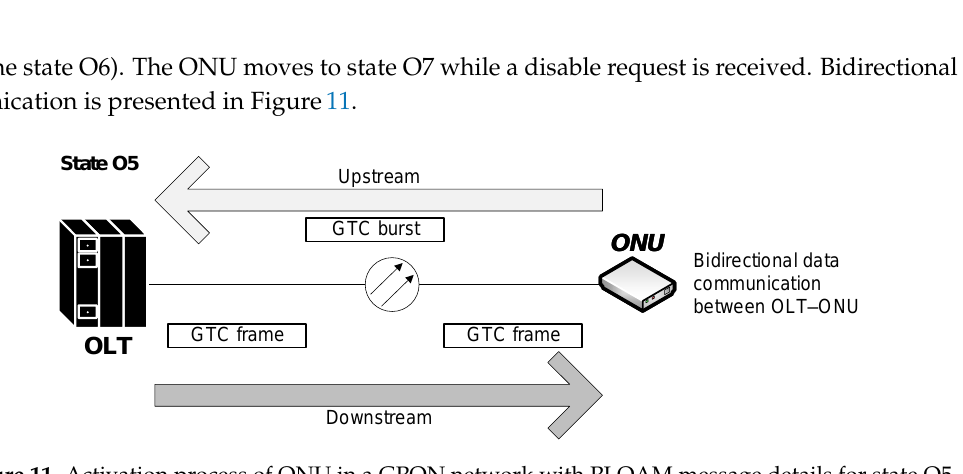
Figure 11. Activation process of ONU in a GPON network with PLOAM message details for state